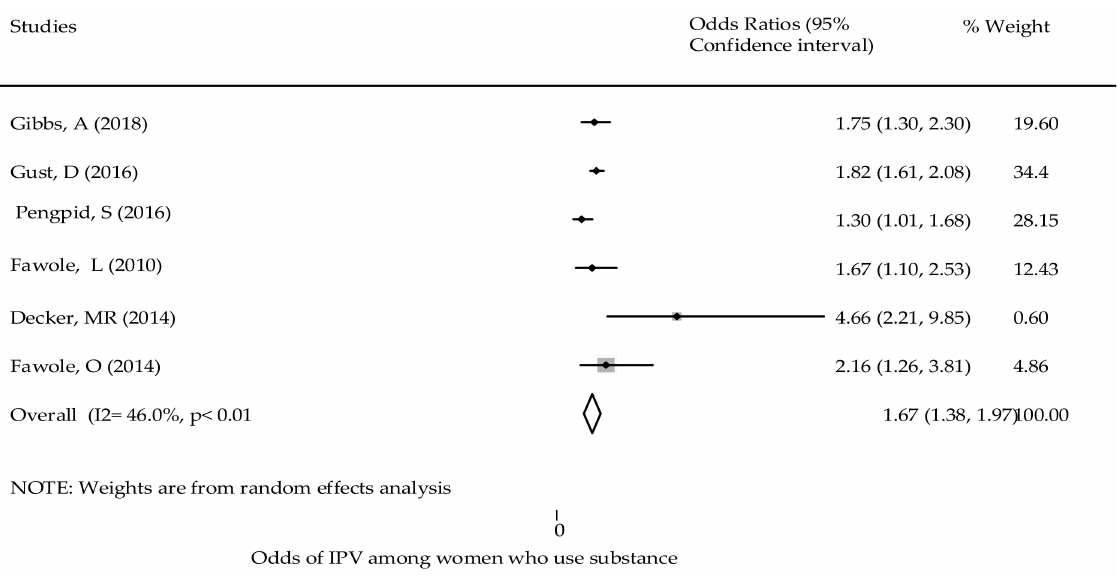
Figure 4. The association of substance use and the experience of reporting GBV in